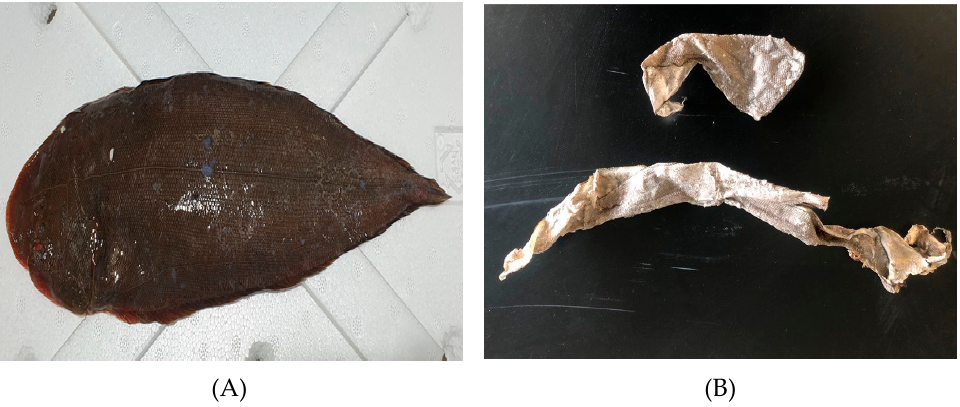
Figure 1. Cynoglossus semilaevis ( A ), a by-product of Cynoglossus semilaevis shell( B ) .